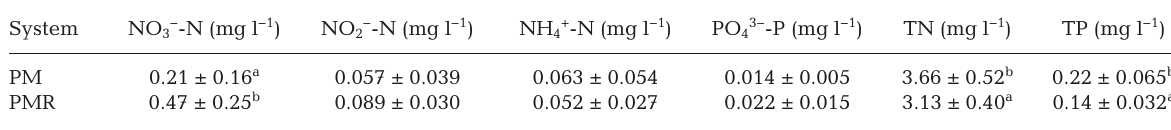
(21.9 µg m −2 h −1 in the PM and 11.2 µg m −2 h −1 in the PMR). Table 2. Concentrations of water nutrients in different polyculture systems (PM and PMR, defined in Table 1) during the farming season (mean ± SD). Data in the same column with different superscripts indicate significant differences (p <